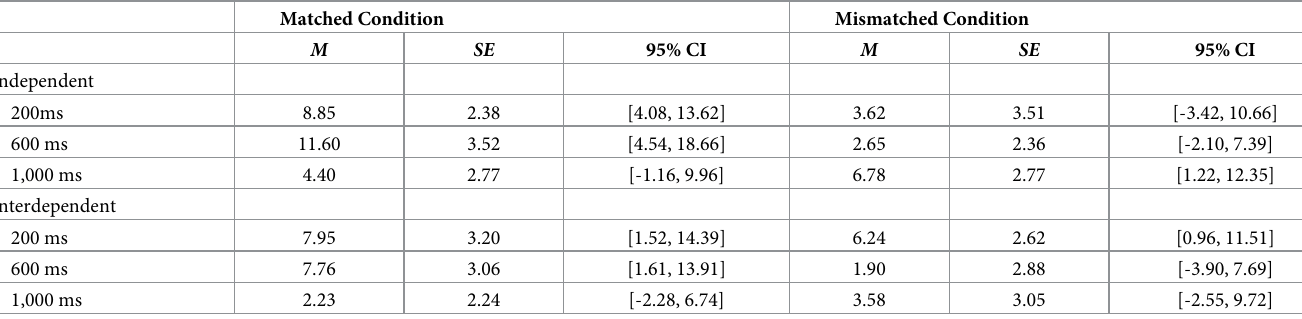
Table 4. Cueing effect indices for European